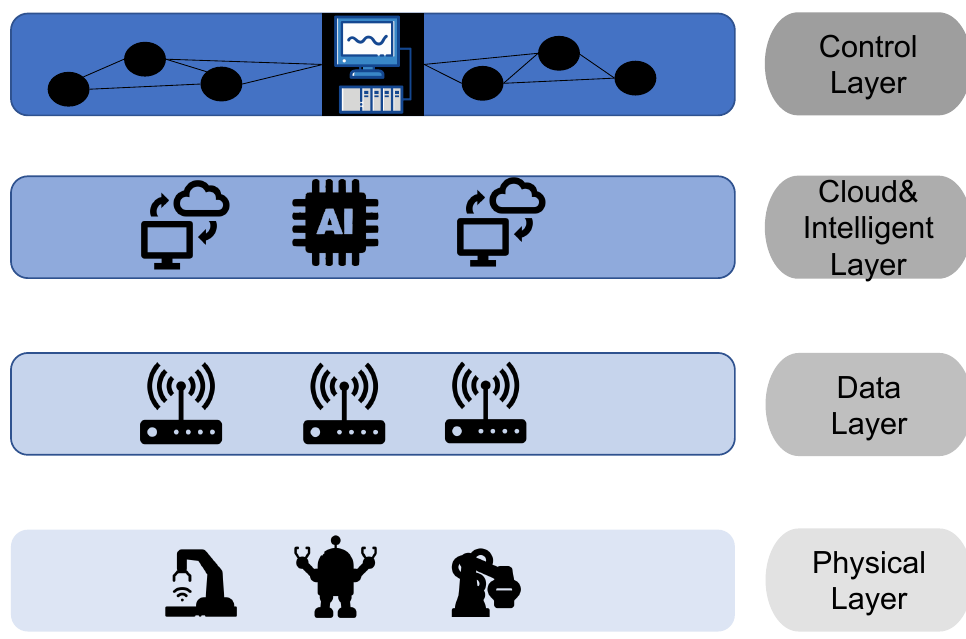
Figure 2. Industry 4.0